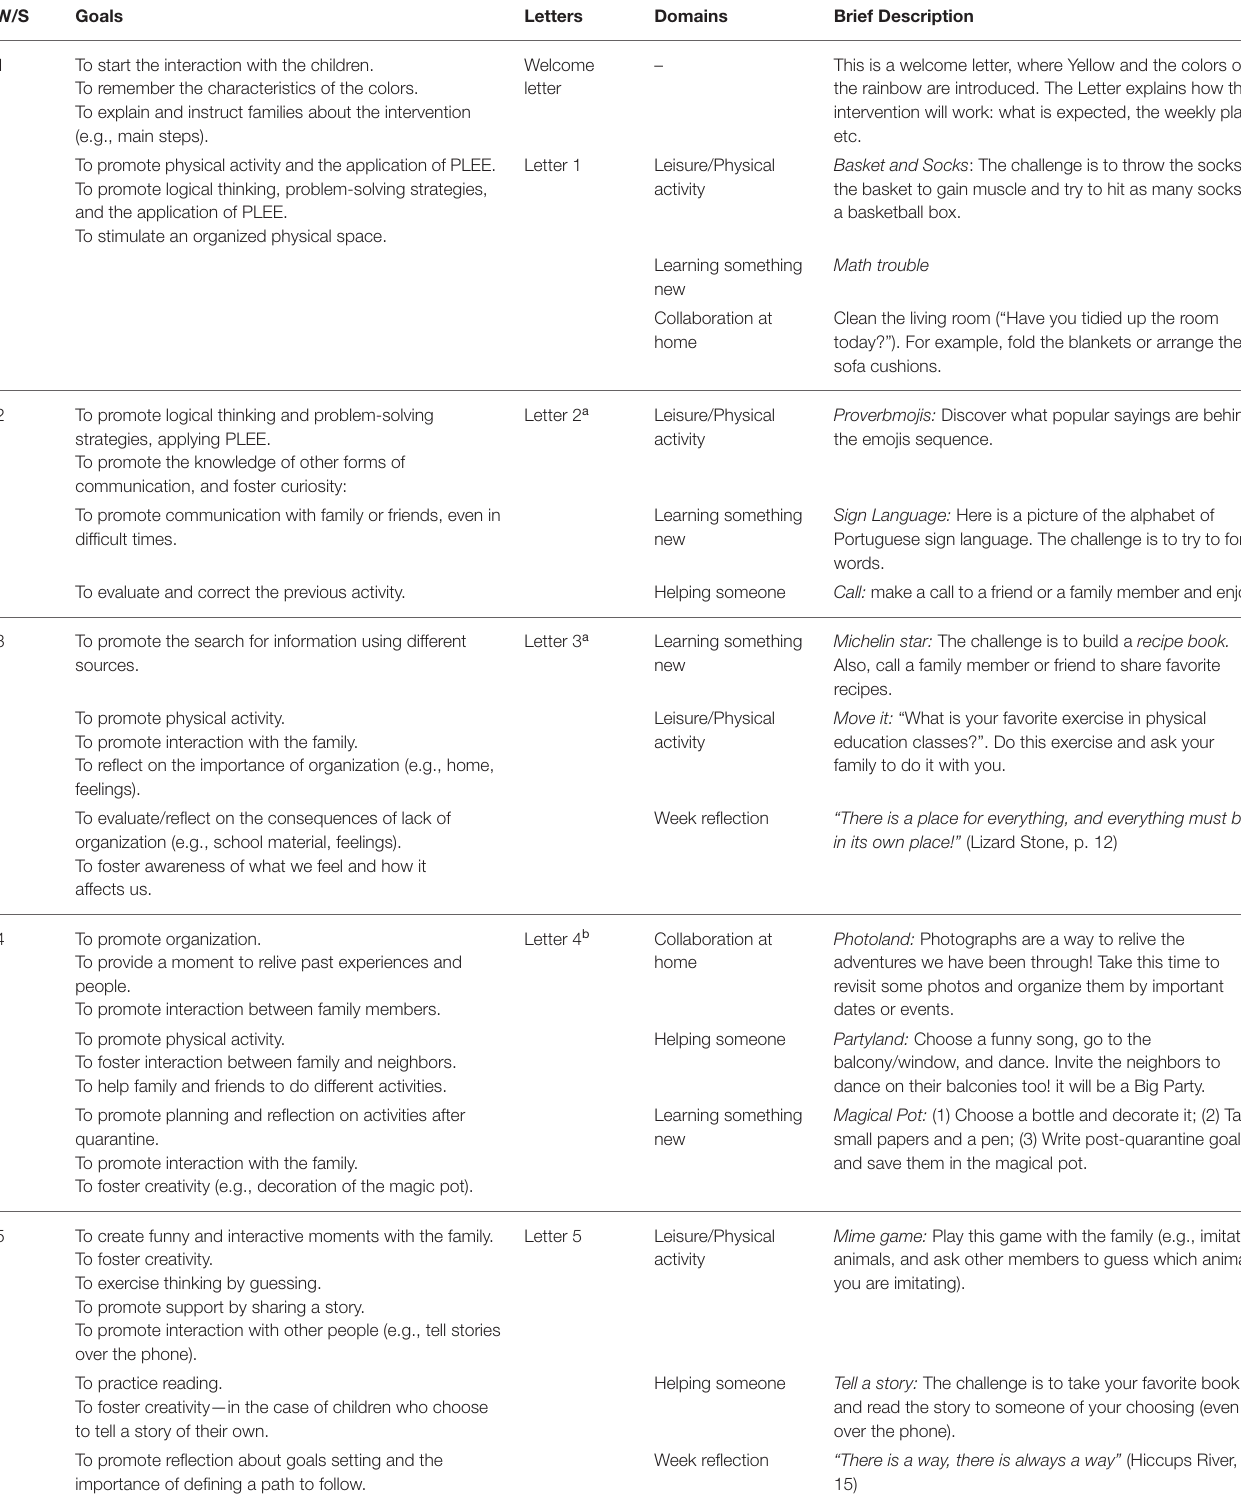
TABLE 3 | Anatomy of the intervention using letters: a week-by-week description of the goals, domains, and related activities. W/S Goals Letters Domains Brief Description